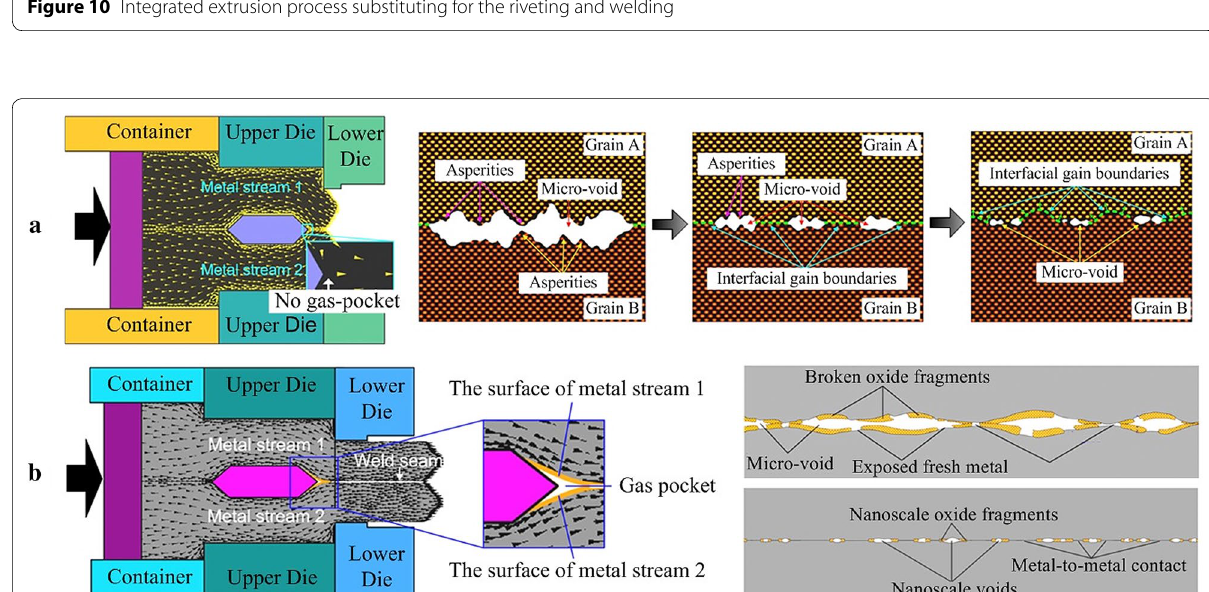
Figure 11 Interfacial structure evolution in the process of portholes extrusion: Schematic diagrams of the interfacial bonding mechanism in the porthole die extrusion process: a without a gas-pocket and b with a gas-pocket (Reproduced from Ref.